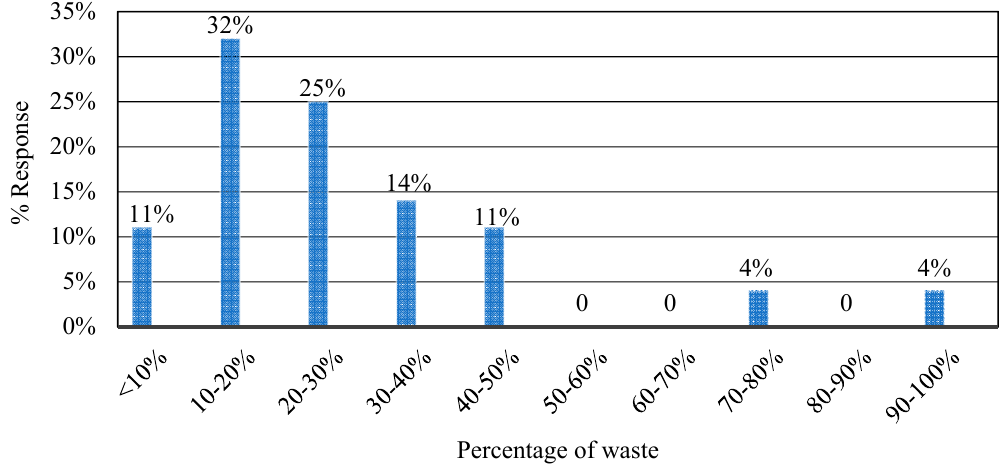
Figure 8. Percent response regarding the effectiveness of Lean methodology.